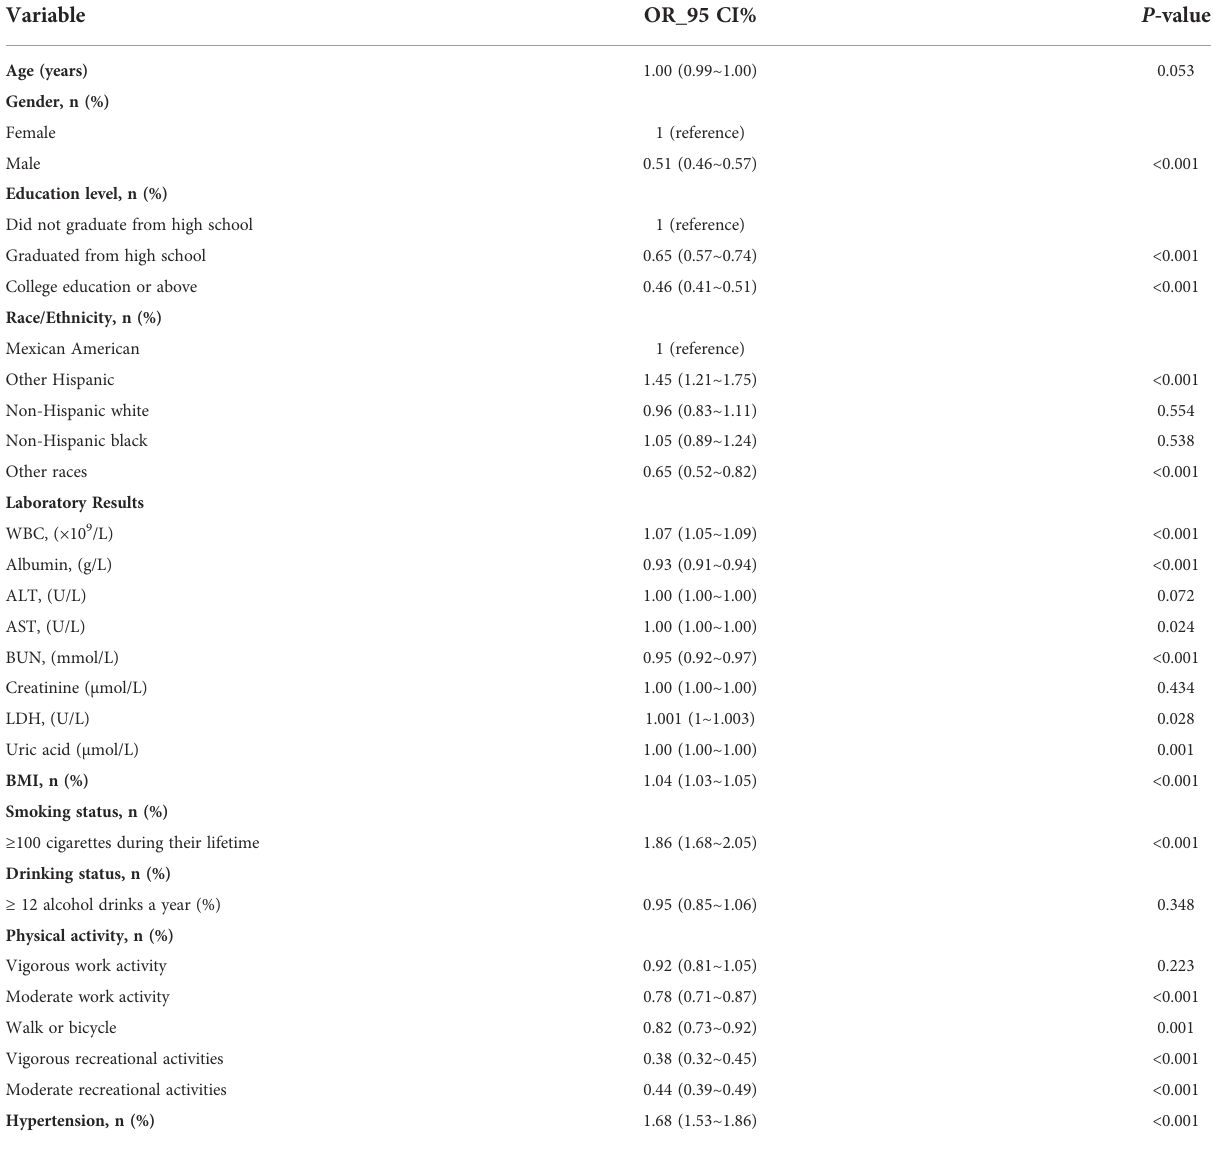
TABLE 2 Association of covariates and depression